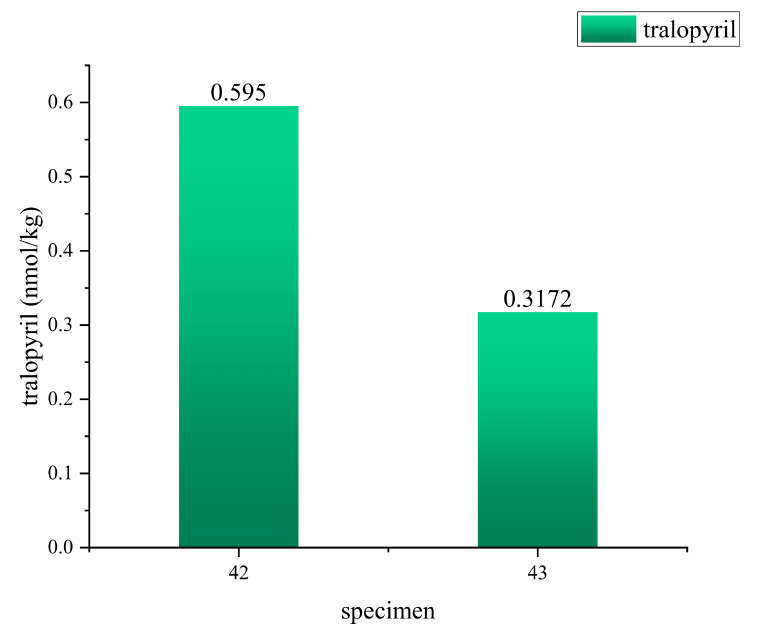
Figure 2. Metabolism of conjugates 42 and 43 in P.